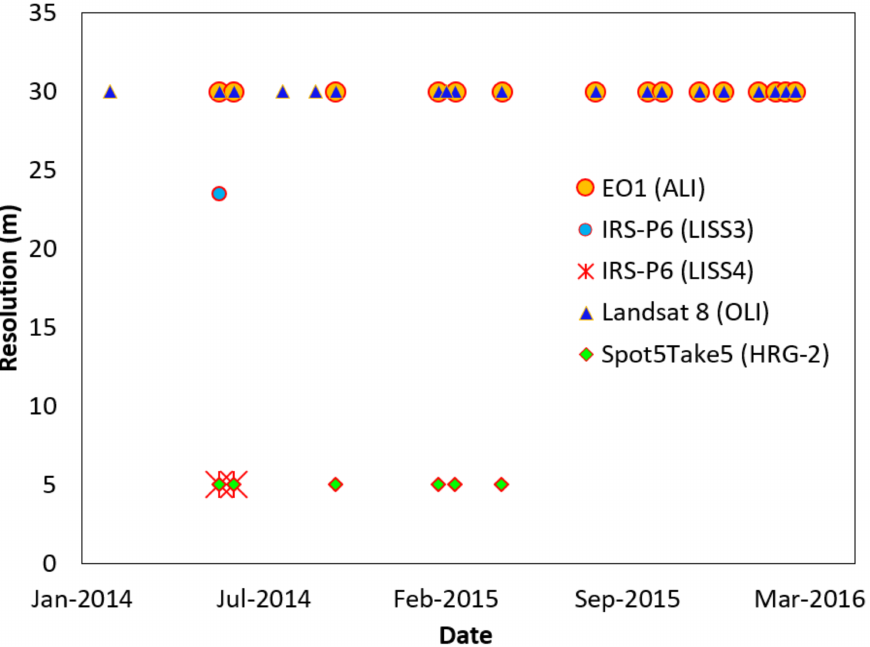
Figure 2. Temporal frequency and resolution of multi-source optical satellite images used in the study. Abbreviations used in the figure are as follows: EO1, Earth Observing-1; ALI, Advanced Land Imager; IRS-P6, Indian Remote-Sensing Satellite-P6 also known as ResourceSat-1; LISS3, Linear Imaging Self Scanning Sensor-3; LISS4, Linear Imaging Self Scanning Sensor-4; OLI, Operational Land Imager; HRG-2, High Resolution